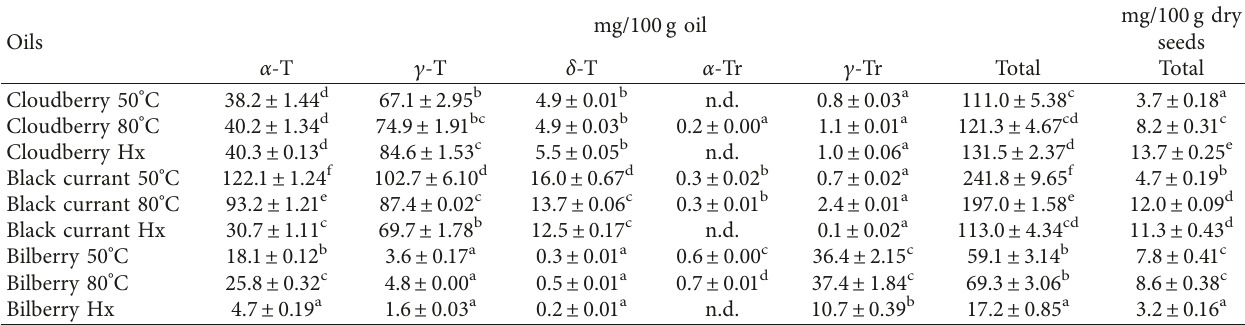
Table 2: Content of tocopherols (T) and tocotrienols (Tr) in cloudberry, black currant, and bilberry seed oils extracted by SFE at different temperatures and by hexane